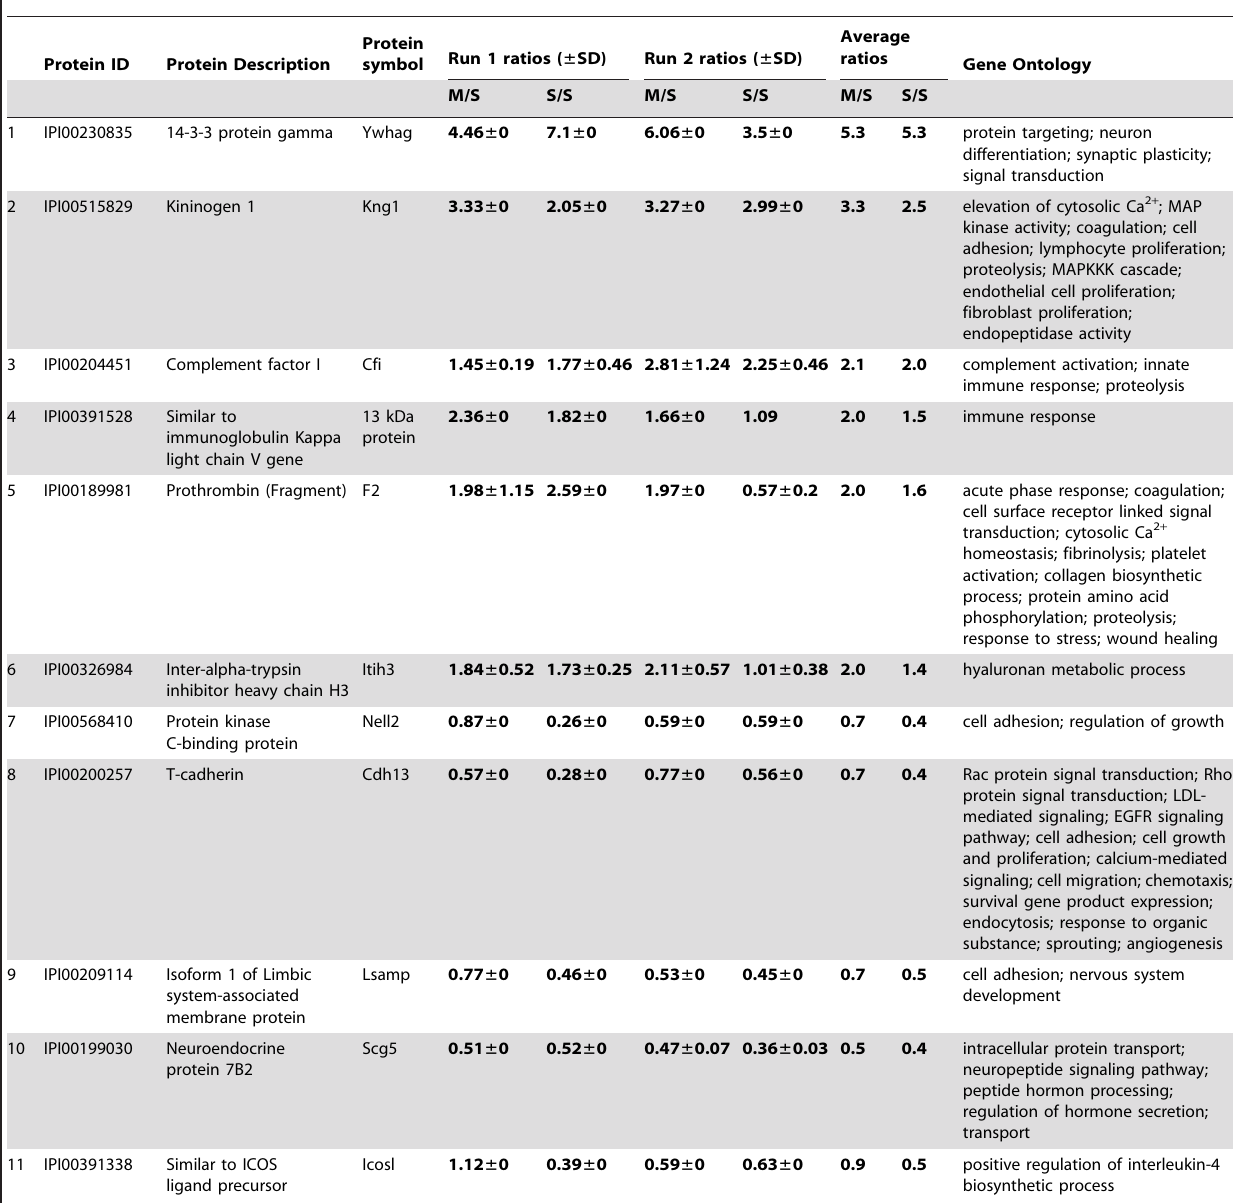
Table 2. Potential biomarkers of SCI identified by quantitative LC-MS/MS analysis of CSF from rats following experimental SCI.